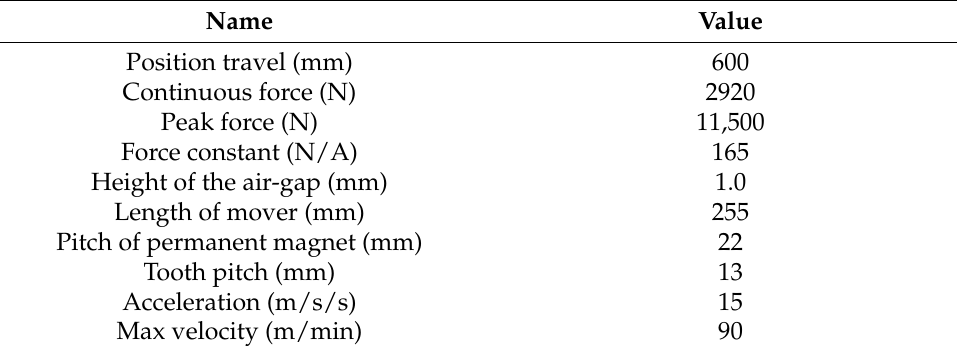
Table 1. The main parameters of direct drive feed system.